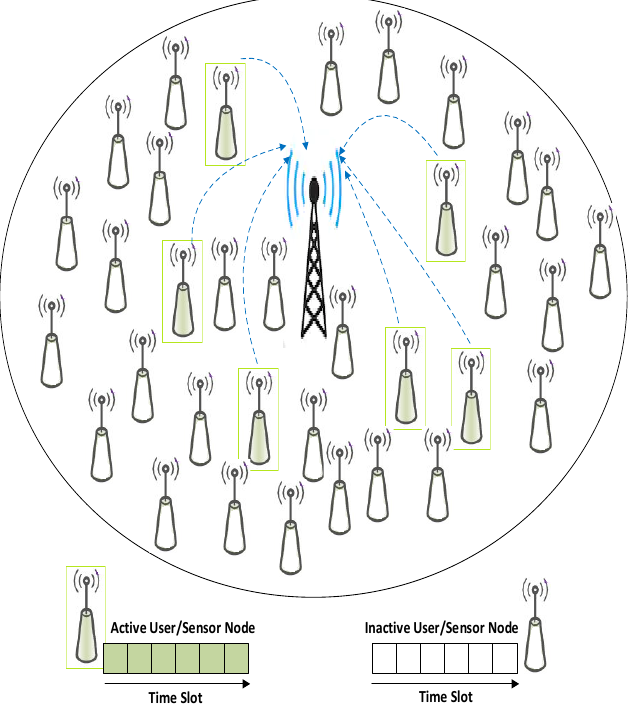
Figure 1. Typical Uplink GF-NOMA network with a small number of active users among multiple inactive users.